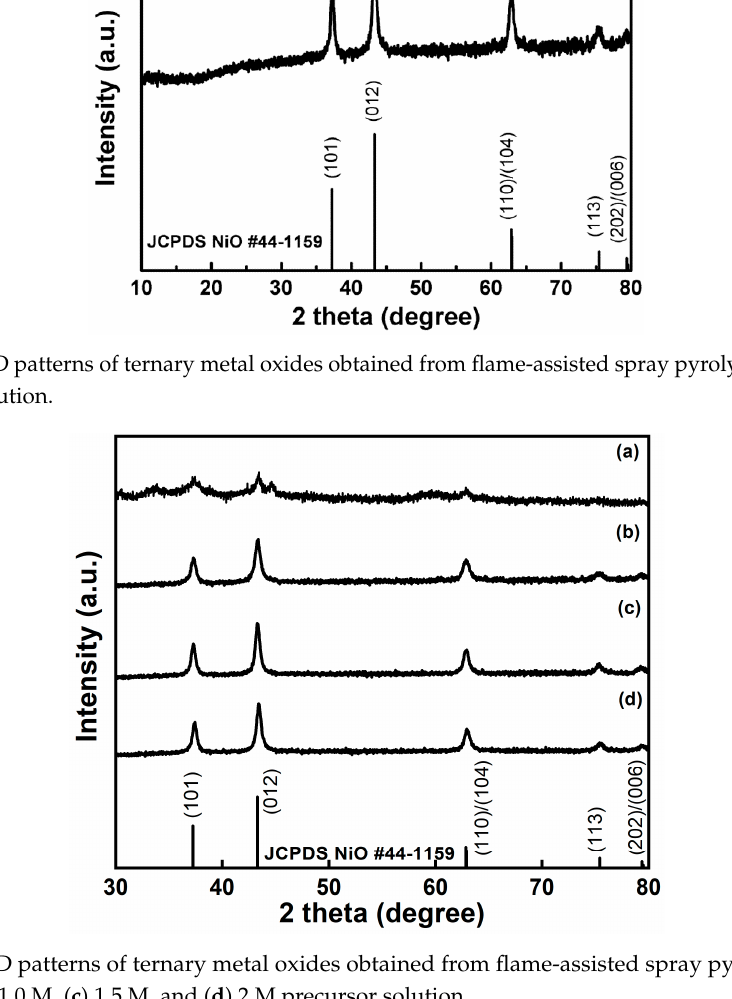
Figure 5. XRD patterns of ternary metal oxides obtained from flame-assisted spray pyrolysis using 1 M precursor solution.